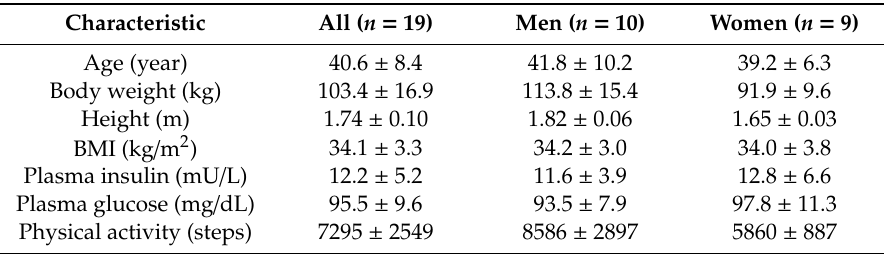
Table 1. Baseline characteristics of study participants 1 .